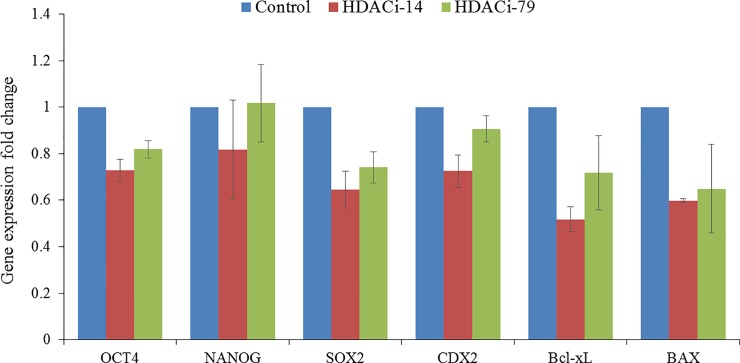
Expression of pluripotency-related genes (Oct4, Nanog, Sox2, Bcl-xL, Bax, and Cdx2) in cloned porcine blastocysts cultured in the medium supplemented with HDACi-14 (2 μM) or HDACi-79 (2 μM).Three replicates.